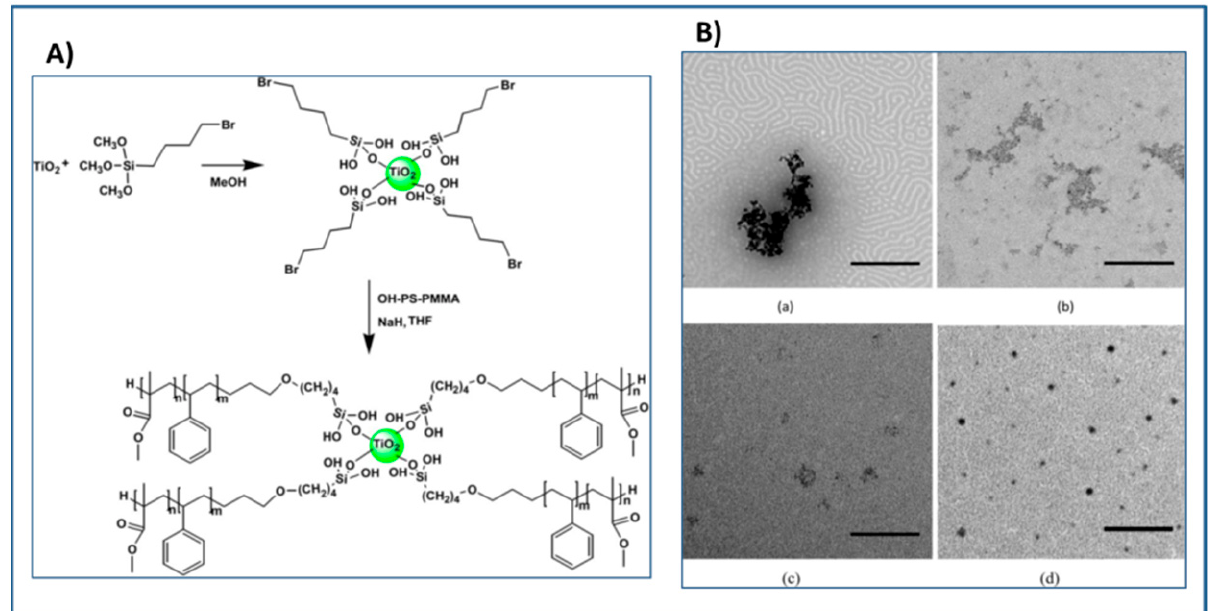
Figure 18. ( A ) Scheme for synthesis of PMMA-b-PS - g -TiO 2 nanoparticles; ( B ) TEM (no stain) images of ( a ) oven annealed pristine TiO 2 (10 wt%)-BCP (57 k-b-25 k) composite ( b ) As-cast PS (60 k) with 10 wt% BCP- g -TiO 2 ( c ) As-cast PMMA (33 k) with 10 wt% BCP- g -TiO 2 , and ( d ) Oven annealed PMMA (33 k) with 10 wt% BCP- g -TiO 2 . (scale bar: 0.5 µm). Reproduced with permission from Ref [221].